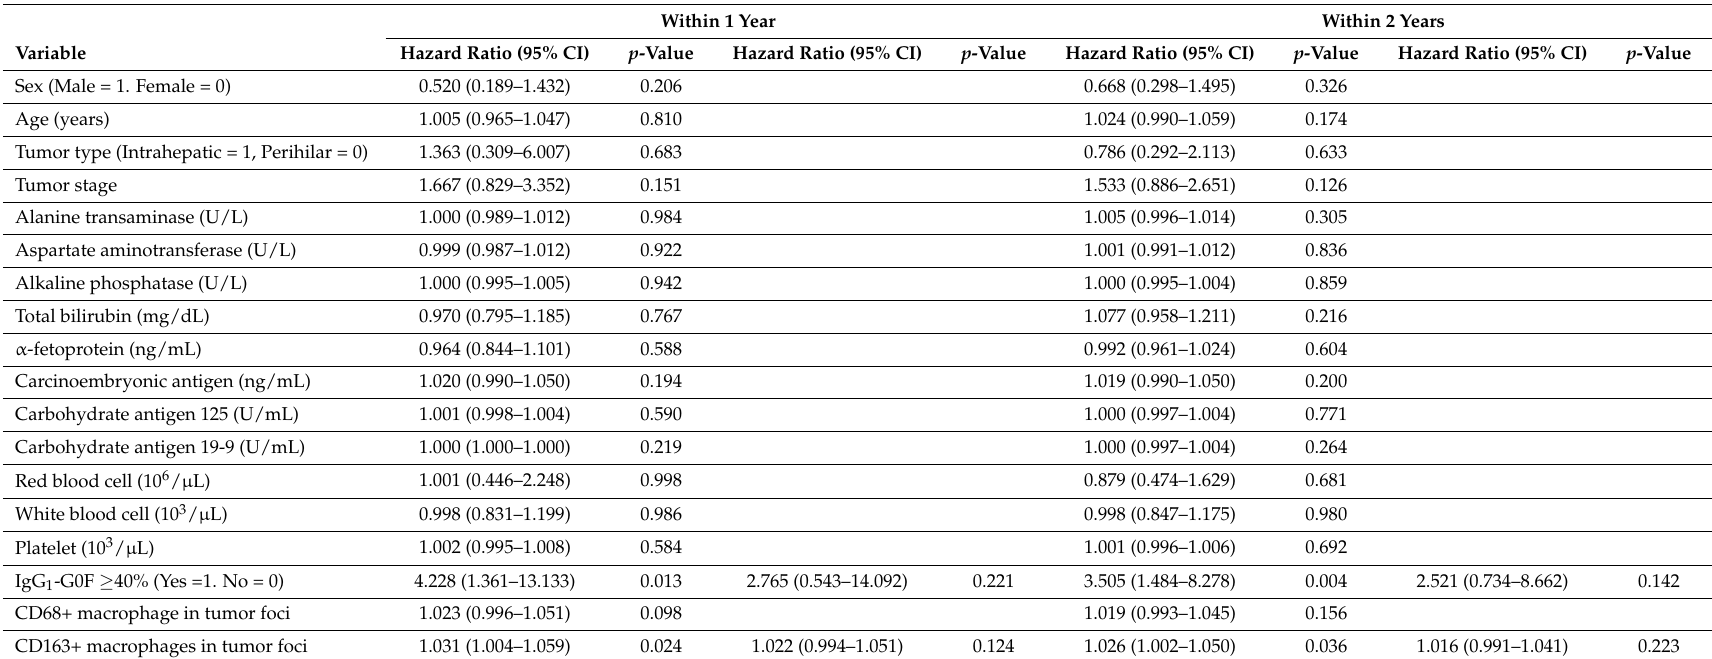
Table 4. Cox regression analysis of early cholangiocarcinoma